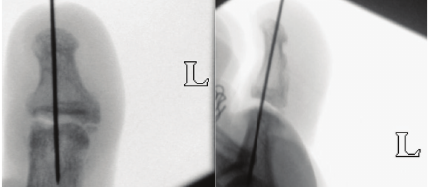
Figure 4: These are intraoperative image-intensifier images of the IP joint being held in reduction by the percutaneously inserted